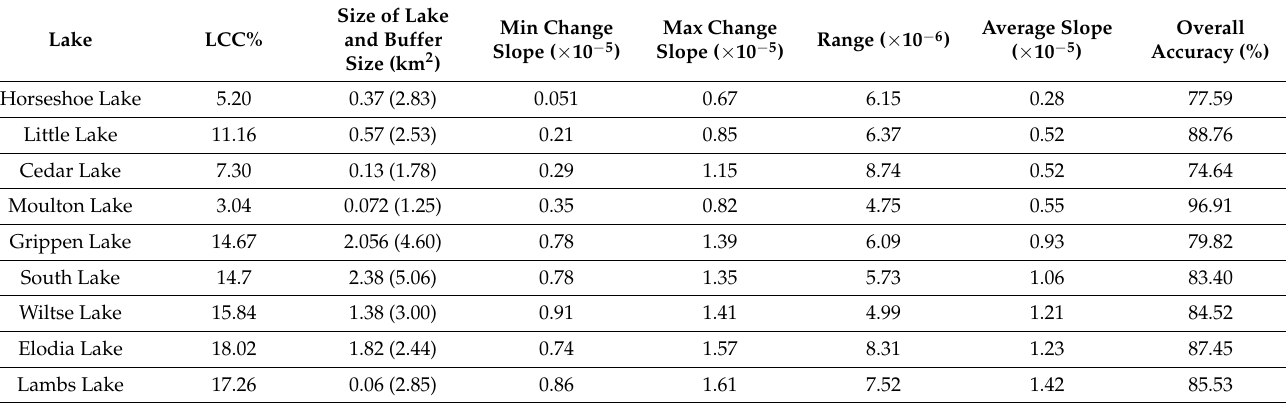
Table 3. Summary of the temperature change slopes and LCC accuracy for nine